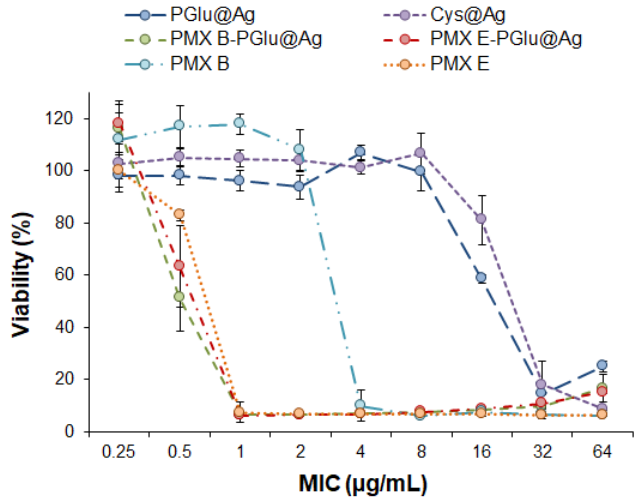
Figure 12. Antimicrobial activity of free polymyxins B and E, hybrid nanoparticles, and their nanoformulations against Pseudomonas aeruginosa . The data are given as mean ± SD (n = 3).